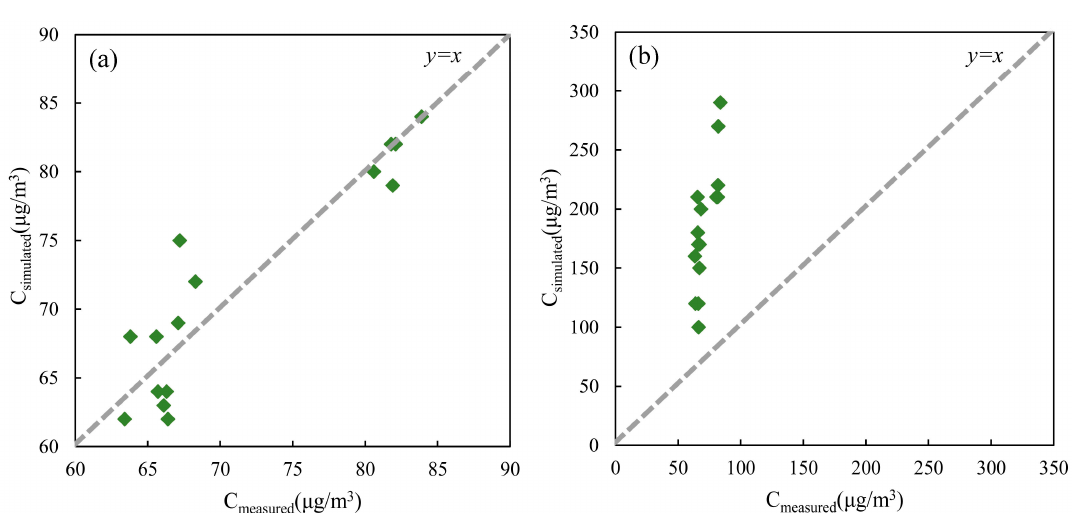
Table 4. Hybrid emission factors for different vehicle classes by multiple regression (g/km).